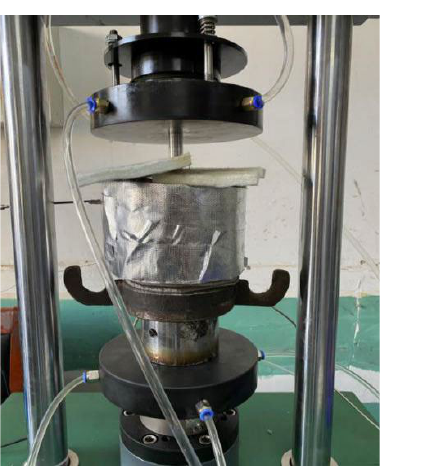
Figure 4. Equipment setup (1. data acquisition system; 2. temperature measurement system; 3. temperature control system; 4. cooling system; 5. universal testing machine; 6. nitrogen bottle; 7. electric heater).